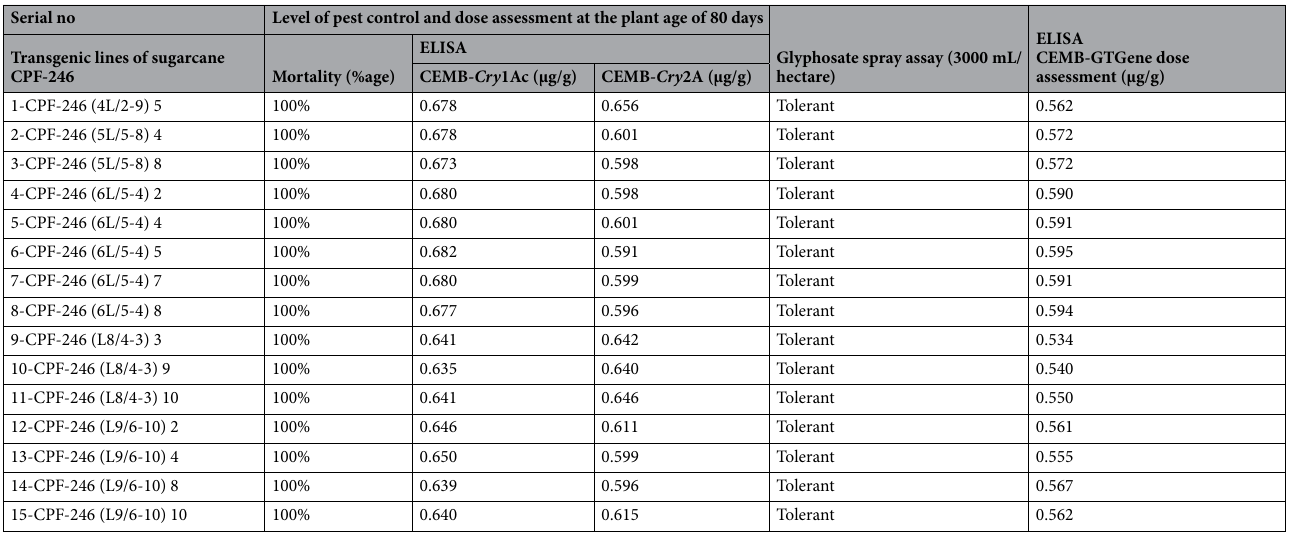
Table 10. Level of pest control and dose assessment of CEMB- Cry 1Ac, CEMB Cry 2A (µg/g) and CEMB- GTGene (µg/g) from five transgenic sugarcane lines in V 2